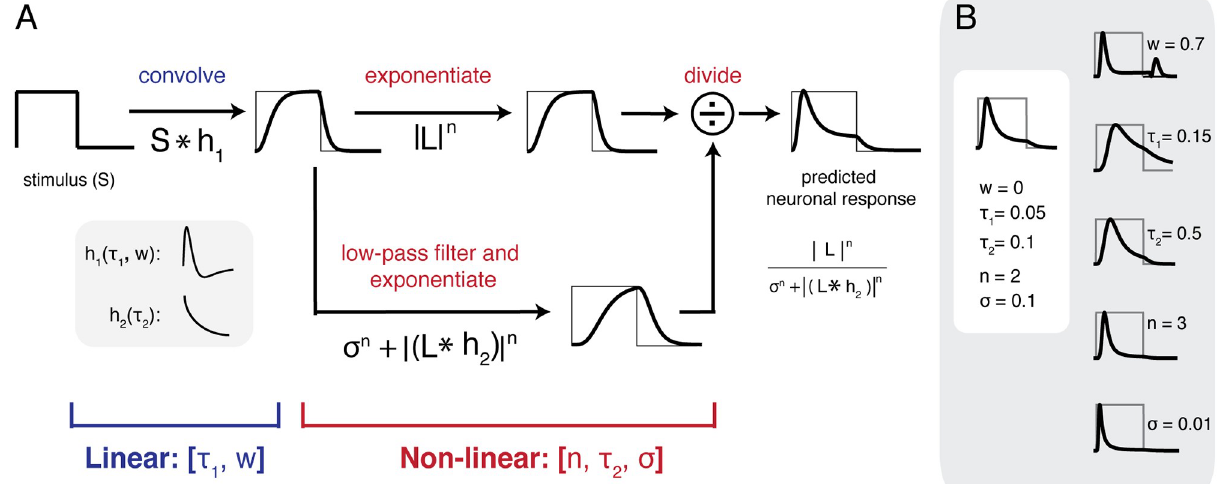
Fig 2. The delayed normalization (DN) model. (A) The input to the model is the contrast time course of a stimulus, S , which is 0 when the stimulus is absent and 1 when it is present. First, the model computes the linear neuronal response by convolving S with an impulse response function h (parameterized by τ 1 and w ). The linear output is then full-wave rectified and exponentiated by n . We assumed n > 1 in this paper. The exponentiated output is divisively normalized by a denominator that consists of two components: a semi-saturation constant ( σ ), and a causally low-pass filtered version of the driving signal. Both components were raised to the same power n . The predicted neuronal response (right) to the example input stimulus S (left) includes a transient followed by a lower-level, more sustained response. (B) The effects of varying each of the 5 parameters are shown. For example, larger w means a more biphasic impulse response, therefore a larger transient response at stimulus offset (top row). In all simulations, the default parameters are w = 0, τ 1 = 0.05, τ 2 = 0.1, n = 2, σ = 1. For more details of model behavior see S1 Fig.